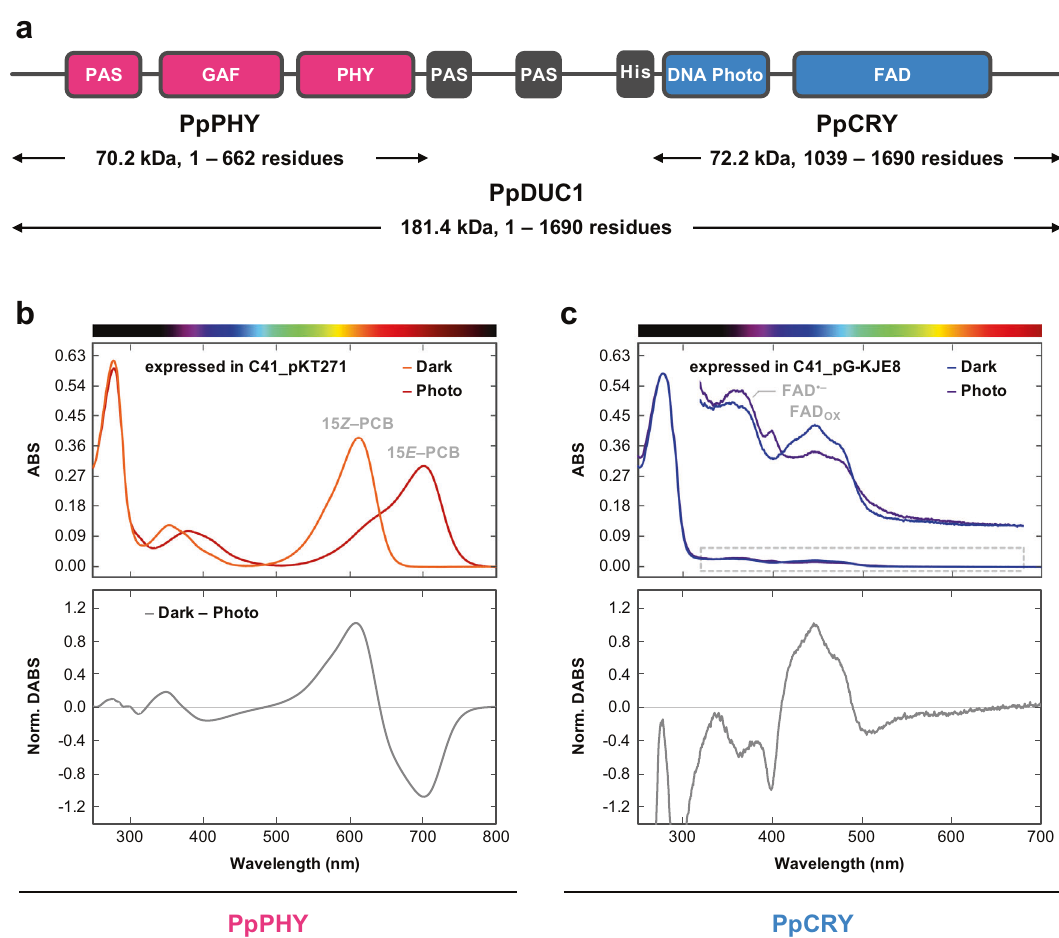
Fig. 2 Photoconversion of PpPHY and PpCRY. a Domain structure of PpDUC. PpPHY (magenta) and PpCRY (cyan) regions are shown with their molecular sizes and amino acid positions. b Absorption spectra of the dark state (15 Z – PCB, Po form) and the photoproduct state (15 E – PCB, Pfr form) of PpPHY expressed in C41_pKT271 (harboring the PCB-synthetic system). The normalized difference spectrum (dark state — photoproduct state) was calculated from these absorption spectra. c Absorption spectra of the dark state (FAD OX , Pb form) and the photoproduct state (FAD ⋅ – , Puv form) of PpCRY expressed in C41_pG-KJE8 (harboring the chaperone expression system). The normalized difference spectrum (dark state — photoproduct state) was calculated from these absorption spectra. The absorption maxima of PpPHY and PpCRY are reported in Supplementary Table 1. Assignment of chromophores incorporated in PpPHY and PpCRY was performed by comparison with each standard, which are reported in Supplementary Fig.